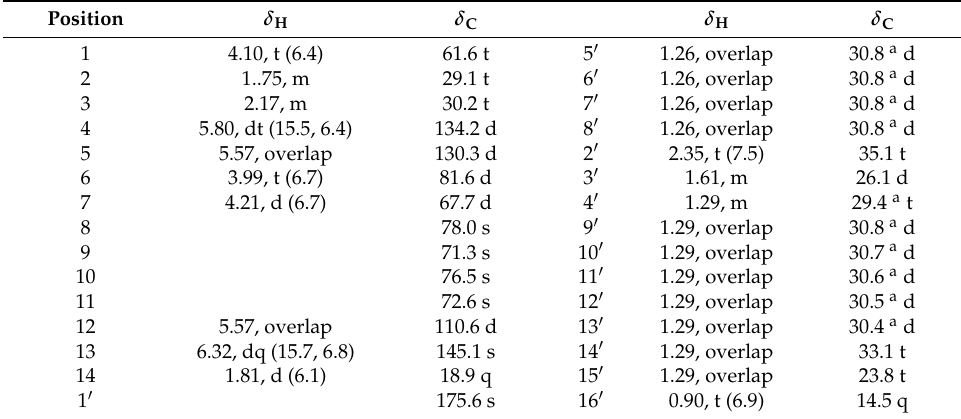
Table 3. 1 H- (400 MHz) and 13 C-NMR (150 MHz) data of 3 in methanol- d 4 ( δ in ppm, J in